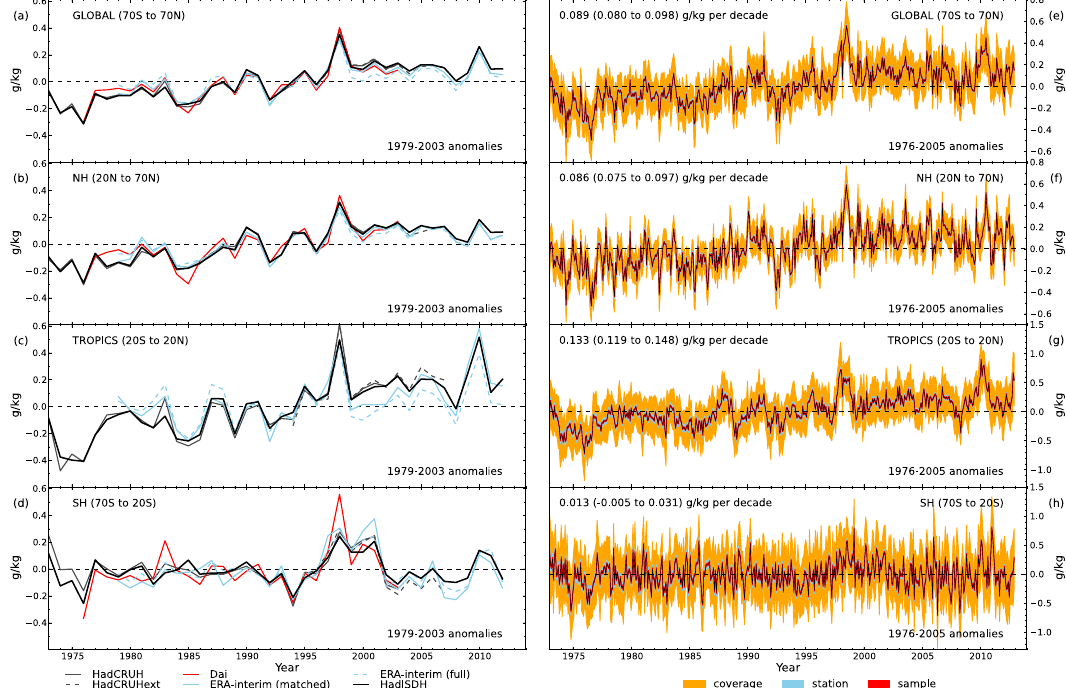
Fig. 10. Time series of large-scale average specific humidity over land for HadISDH and existing data products. (a – d) Annual time series from all other global surface humidity products given a zero mean over the common period of 1979–2003. Dai covers 60 ◦ S to 70 ◦ N. ERA-Interim has been weighted by % land coverage in each grid box and is shown both spatially matched to HadISDH and with complete coverage. (e – h) Monthly time series (relative to the 1976–2005 climatology period) for HadISDH with 2 σ uncertainty estimates. The black line is the area average (using weightings from the cosine of the latitude). The red, blue and orange lines show the ± combined uncertainty estimates from the grid-box sampling uncertainty, the station uncertainty and the spatial coverage uncertainty, respectively. Decadal trends are shown for each region for the period 1973–2012. These have been fitted to the monthly-mean anomaly time series using the median of pairwise slopes as described in Fig. 9, with the 95% confidence intervals shown. Where these are both of the same sign (i.e. the globe, Northern Hemisphere and tropics) there is high confidence that trends are significantly different from